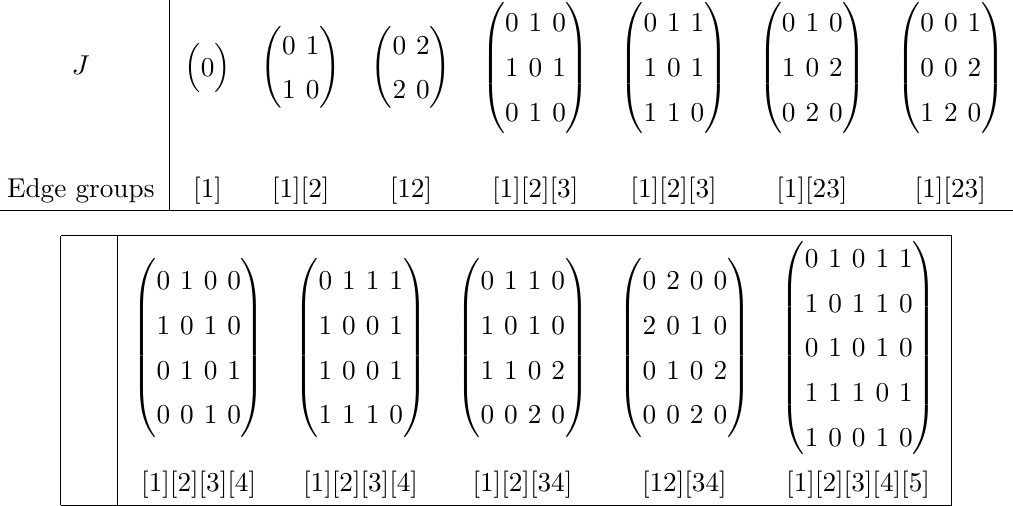
Table 1 . Edge-adjacency matrices and the corresponding Wick-edge groups for non-periodic cases.